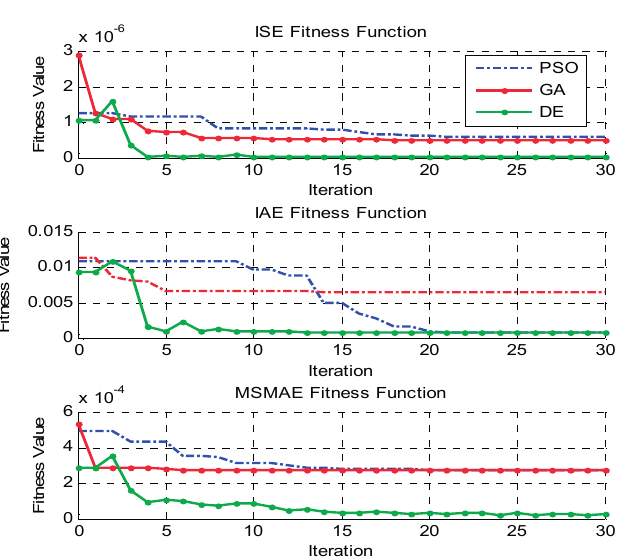
Figure 2. Fitness function best values for linear contour.